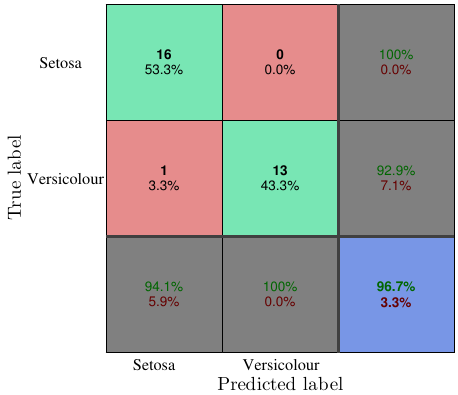
Figure 10. Confusion matrix of the Iris test, software implementation.